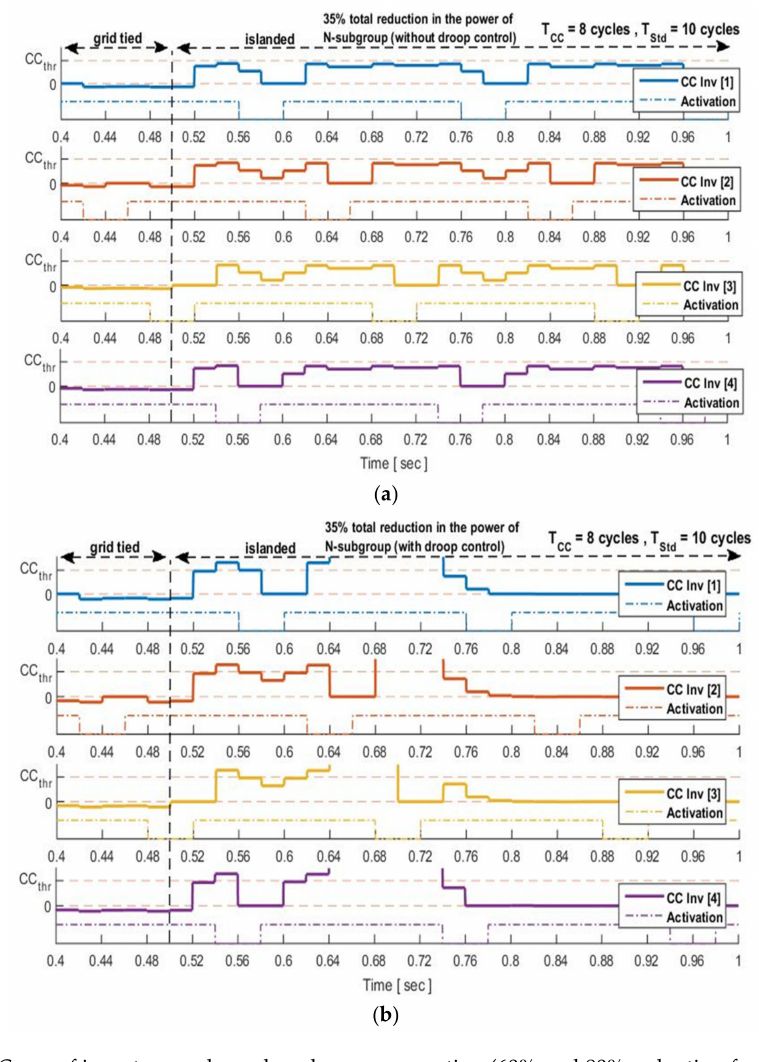
Figure 9. CC index of inverters under reduced power operation (60% and 80% reduction for the inverters 2 and 3, respectively) for l = 4 ( T CC = 8 cycles), ( a ) without droop-controller, ( b ) with droop-controller.